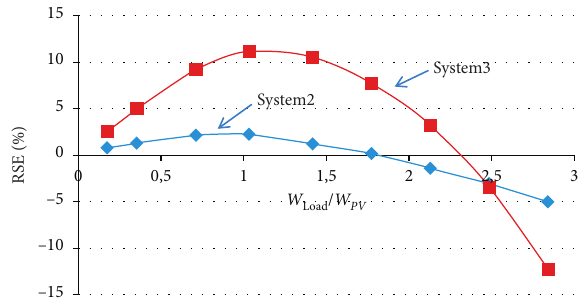
Figure 15: Yearly relative saved energy of classical LVDC system 2 and proposed LVDC system